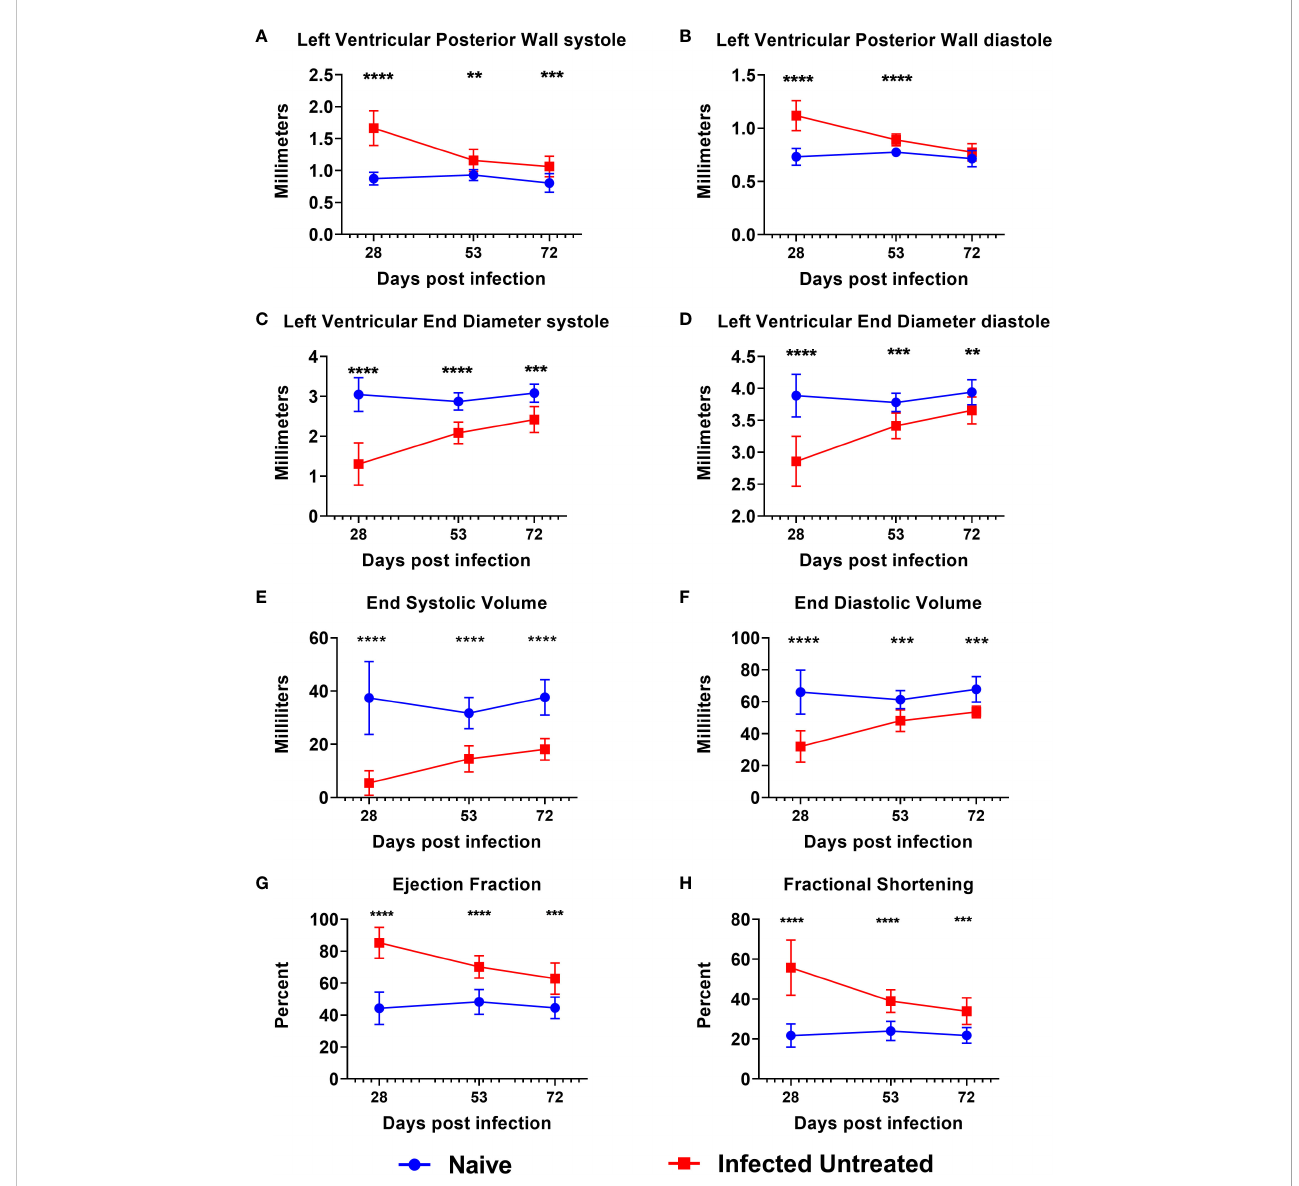
FIGURE 2 Echocardiography evaluation prior to treatment initiation. M-mode images were used to measure parameters at the end of both systole and diastole, including left ventricular posterior wall thickness (A, B) , left ventricular end diameter (C, D) , left ventricular volume (E, F) , ejection fraction (G) and fractional shortening (H) at approximately 28dpi, 53dpi and 70dpi. At each timepoint, infected untreated mice were compared to naïve age matched controls*, p ≤ 0.05; **, p ≤ 0.01; ***, p ≤ 0.001; ****, p ≤